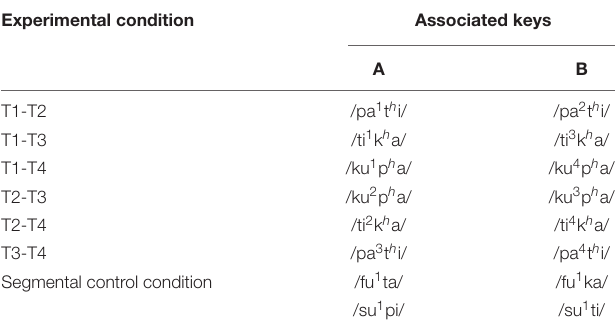
TABLE 1 | Non-word stimuli used in the sequence-recall task. Experimental condition Associated